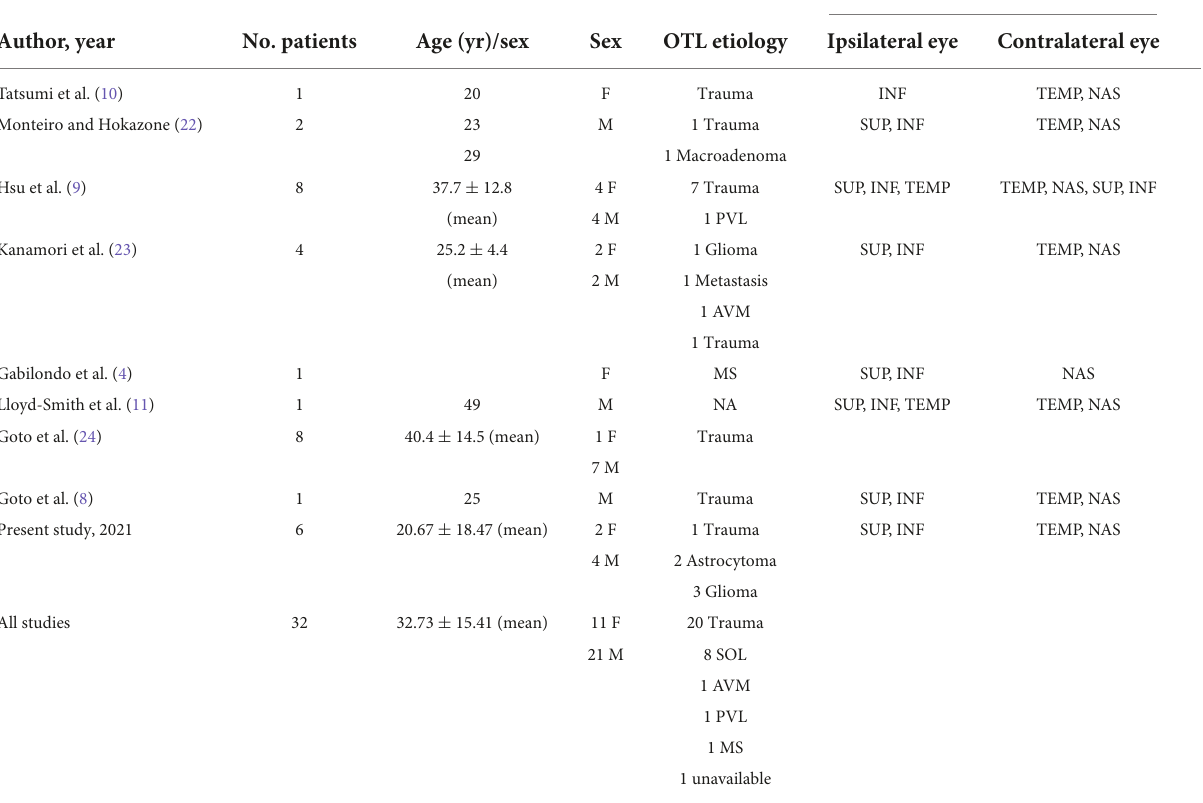
TABLE 1 Clinical and OCT findings in patients with OTL: literature